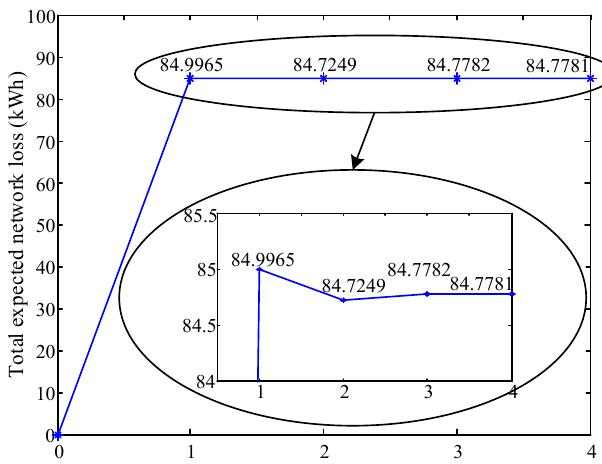
Figure 6. Total expected network loss at each iteration in solving the DAS.